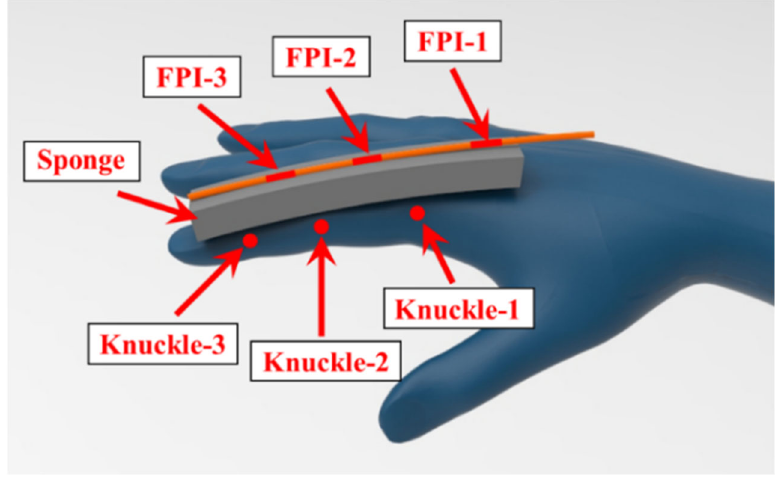
Figure 3. Diagram of pasted sponge and fiber.